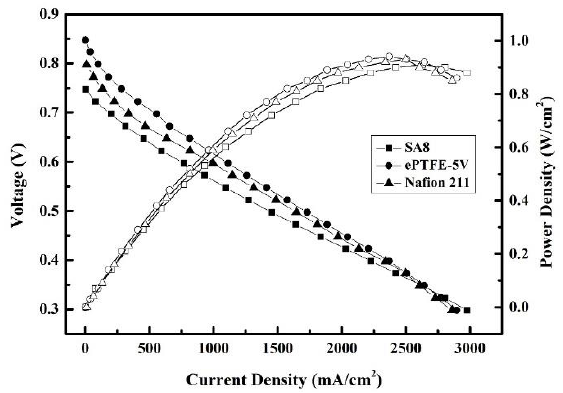
Figure 14. Fuel cell component efficiency of SA8, ePTFE-5 V and Nafion 211 at an intake temperature of 80 °C and relative humidity of 100%RH.